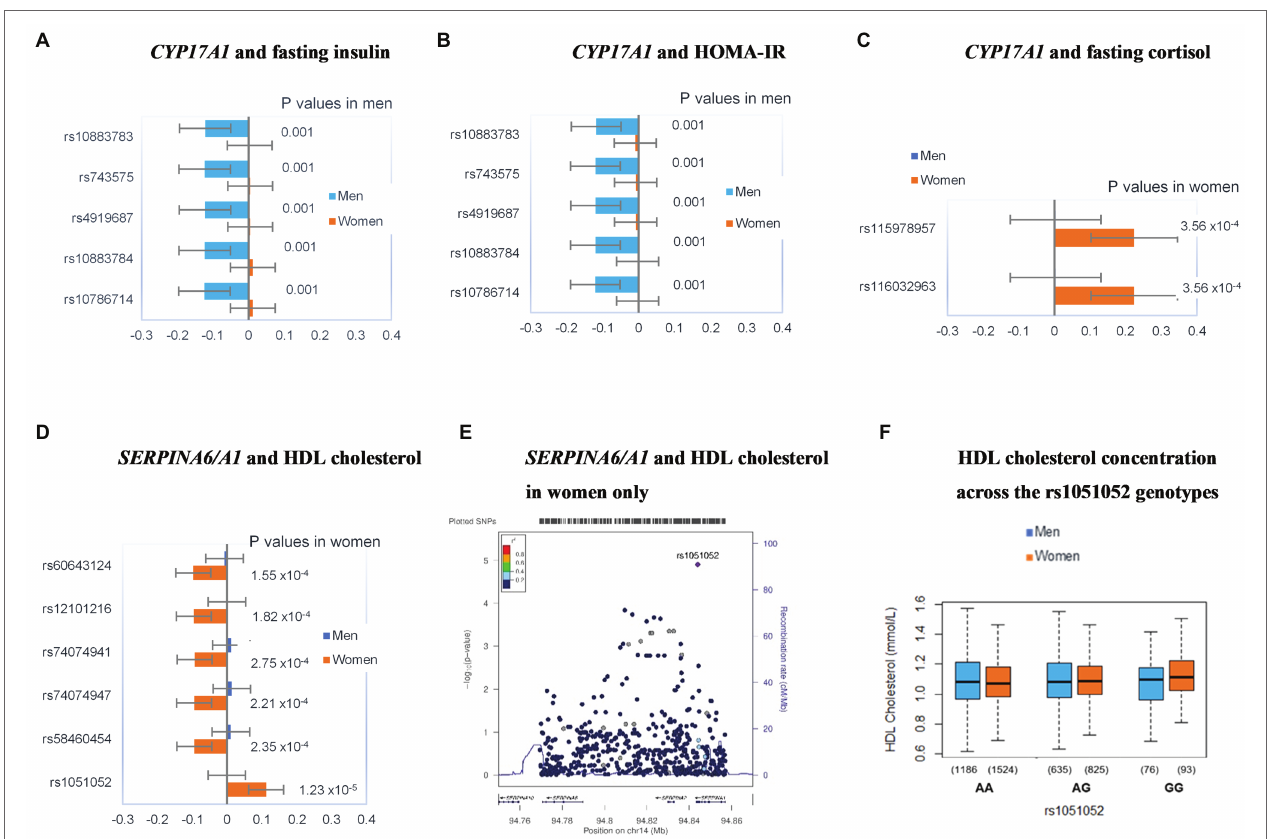
FIGURE 3 | Sex-specific genetic associations between CYP17A1 (A-C) and SERPINA6/A1 (D–F) variants and components of the metabolic syndrome. Plots (A-D) show standardized beta coefficients for the linear regression models after adjusting for age, smoking, alcohol, and BMI. Error bars in these plots represent 95% CIs for the standardized beta coefficients. Values of p are for the respective beta coefficients. The LocusZoom plot summarizes the association between rs1051052 and higher HDL cholesterol concentrations in women (E) . The LocusZoom plot association data was plotted against the AFR LD backgrounds from the 1,000 Genomes Project phase 1 dataset. The rs1051052 SNP is represented by a purple diamond. Each SNP is colored according to the r 2 value against rs1051052. SNPs with missing LD information are colored in gray. The box and whisker plot (F) shows the medians and IQRs of HDL cholesterol concentrations across the rs1051052 genotype groups in men and women. The number of observations in each group is shown in